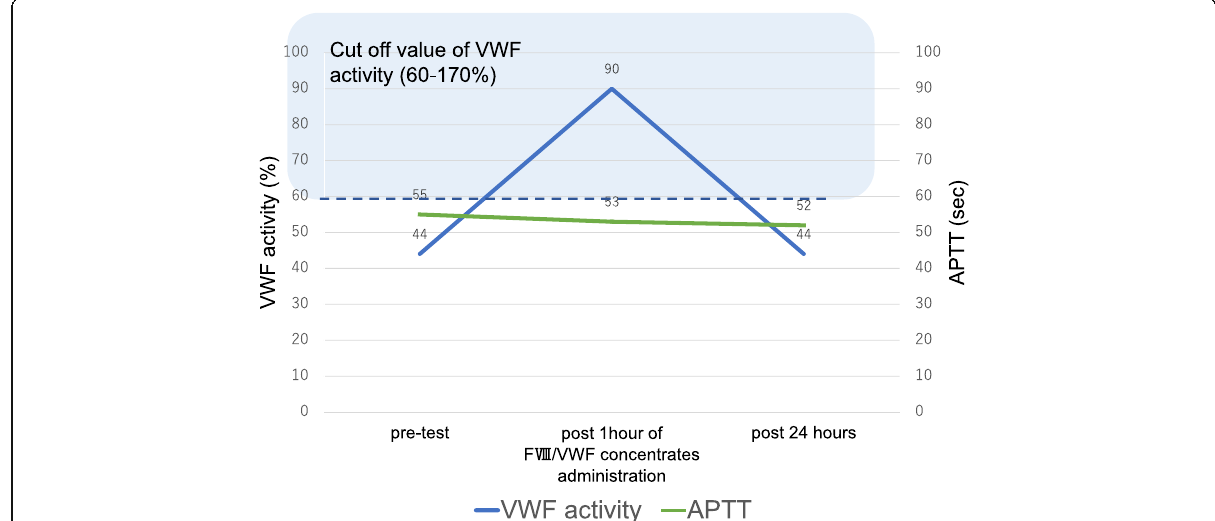
Fig. 1 Change in VWF activity and APTT after test administration of FVIII/VWF concentrates. VWF activity is higher than the reference values at 1 h post-administration VWF: von Willebrand factor, APTT: activated partial thromboplastin